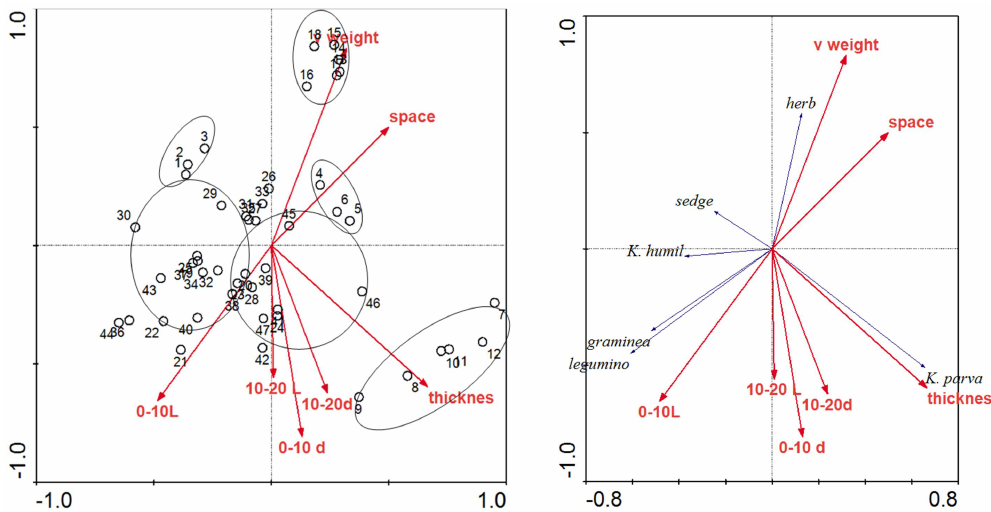
Figure 8. The plant functional groups and environment PCA ordination bioplot. Black items denote plant functional groups, red items denote environmental factors. “V weight” denotes the soil bulk density, “space” denotes the space in community (bared place), “thickness” denotes the thickness of mattic epipedon, 0–10L denotes the live roots in the 0–10cm soil layer, 10–20L denotes the live roots in the 10–20cm soil layer, 0–10d denotes the dead roots in the 0–10cm soil layer, 10–20d denotes the dead roots the 10–20cm soil layer, herb denotes the non-leguminous broad-leaved herb plant functional group, sedge denotes the sedge plant functional group (excluding K. humilis and K. pygmaea ), Gramineae denotes the Gramineae plant functional group, legumino denotes the Leguminosae plant functional group, K. humil denotes the K. humilis , and L. parva denotes the K. pygmaea